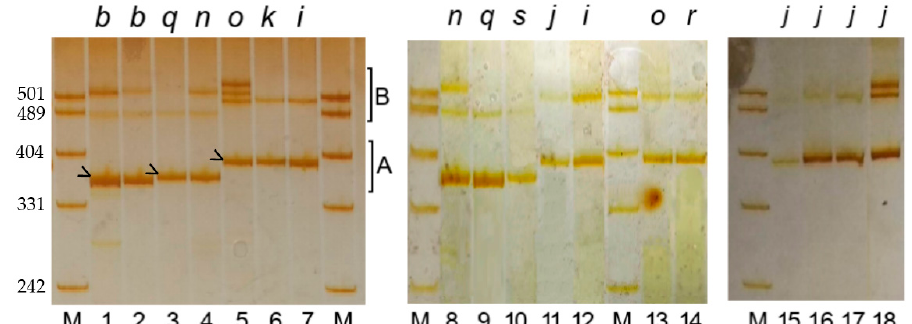
Figure 2. PCR product length polymorphism (GliB1.1 primers) among wheat cultivars. 1, Gabo; 2, Marquis; 3, Goelent; 4, Intensivnaya; 5, Aragon-03; 6, Mentana; 7, Insignia; 8, Intensivnaya; 9, Goelent;